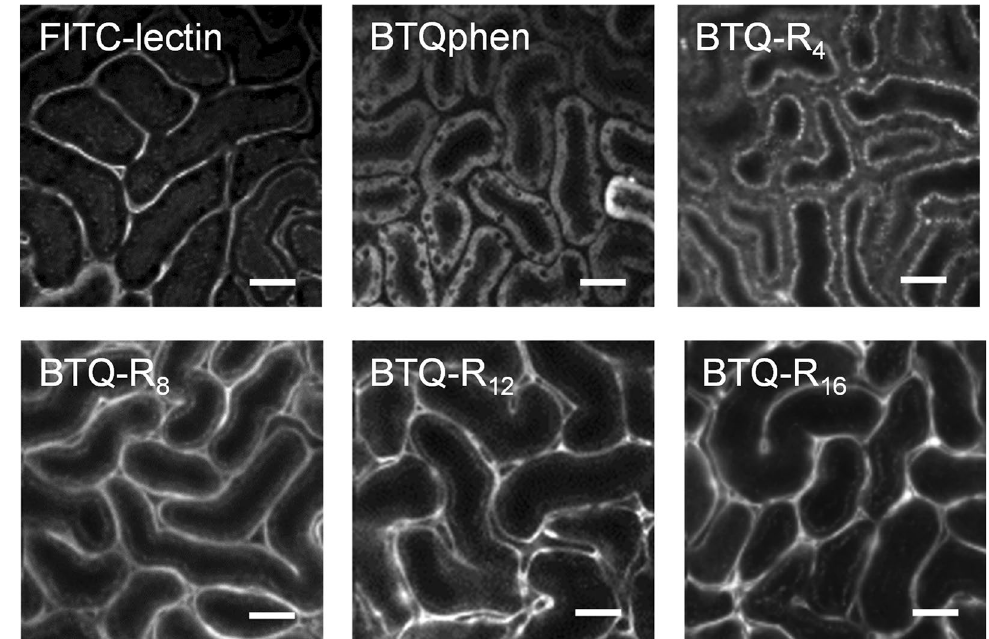
Figure 3. In vivo luminescence intensity images of mouse kidney after intravenous injection of FITC-lectin (1 mg/mL, 50 μL), BTQphen (100 nmol), and BTQ-R n (n = 4, 8, 12, 16) (100 nmol). λ exc : 488 nm, λ em : > 590 nm (BTQ-R 12 ), 510–560 nm (FITC-lectin). Scale bar 50